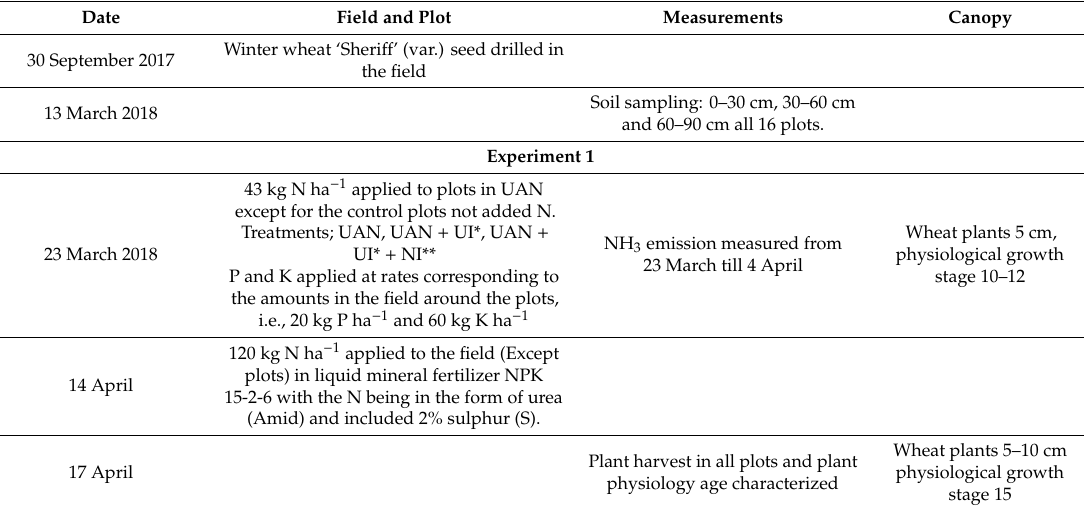
Table 1. Overview of the plots and measurements included in the field